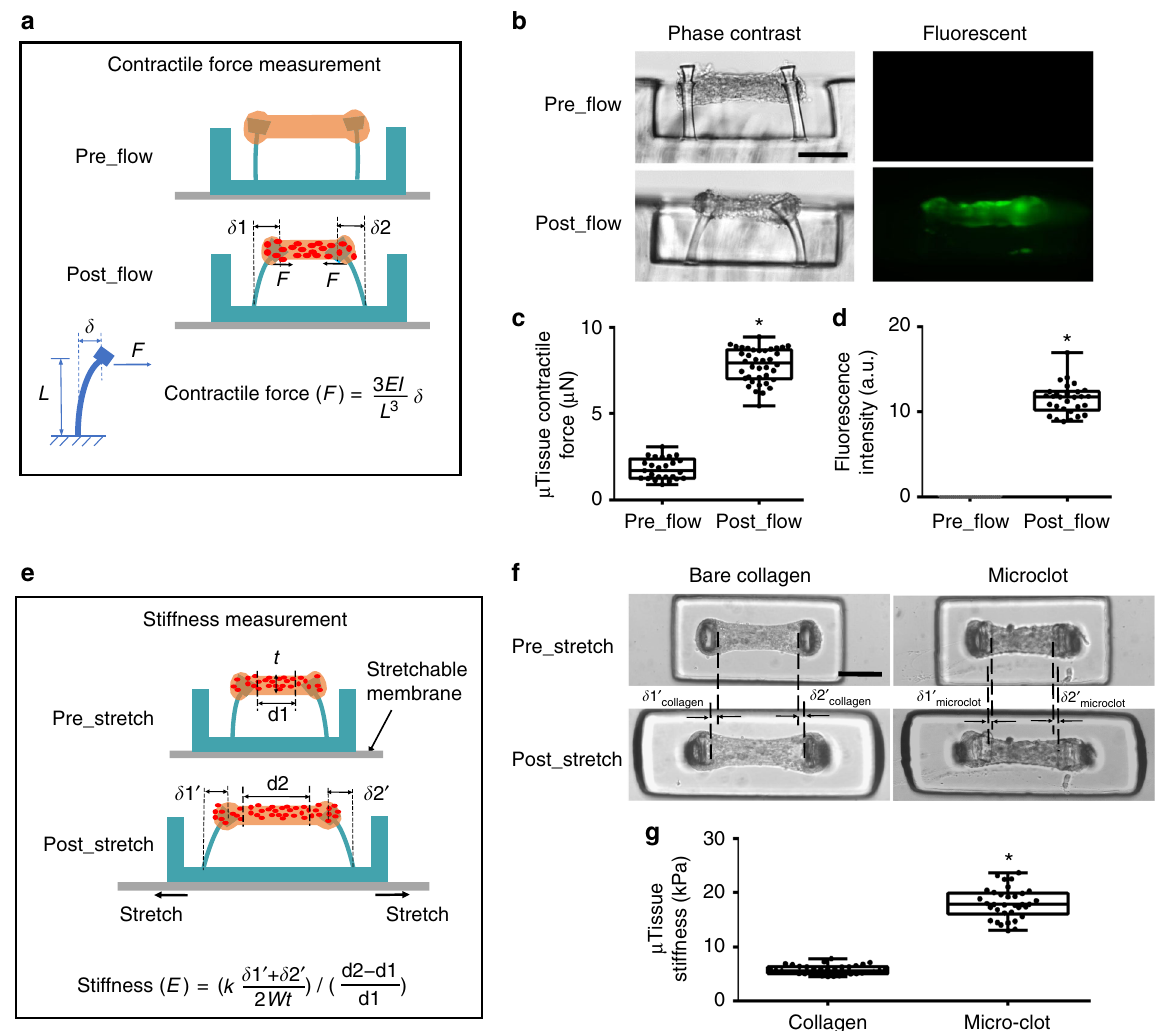
Fig. 2 Measurement of clot contraction and stiffening in the microclot array. Schematic diagram ( a ) and phase contrast and fl uorescence ( b ) sideview images of a microtissue before and after platelet-mediated contraction. Micropillar de fl ection ( δ 1 and δ 2) can be easily detected after platelet adhesion and activation (post fl ow), which was used to calculate microclot-generated contractile force. Comparison of microtissue contractile force ( c ) and fl uorescence intensity ( d ) before and after platelet fl ow. e Schematic diagram of microtissues before and after externally applied stretching. Mechanical stretching caused microtissue elongation ( d 2 – d 1), which was used to calculate tensile strain; the force needed to develop such elongation was reported by micropillar de fl ection as F = k ( δ 1 ′ + δ 2 ′ )/2 which was used to calculate the tensile stress. Microtissue stiffness was determined based on stress − strain relationship. f Comparison of tissue elongation between a microclot and a bare collagen microtissue under the same amount of substrate stretch. g Comparison of the stiffness between microclots and bare collagen microtissues. * P < 0.001, n > 10, each dot in box plot represents an independent experiment. All box plots with whiskers represent the data distribution based on fi ve number summary (maximum, third quartile, median, fi rst quartile, minimum). Statistical signi fi cance was determined by unpaired t test with Welch ’ s correction method. Scale bar is 200 µ